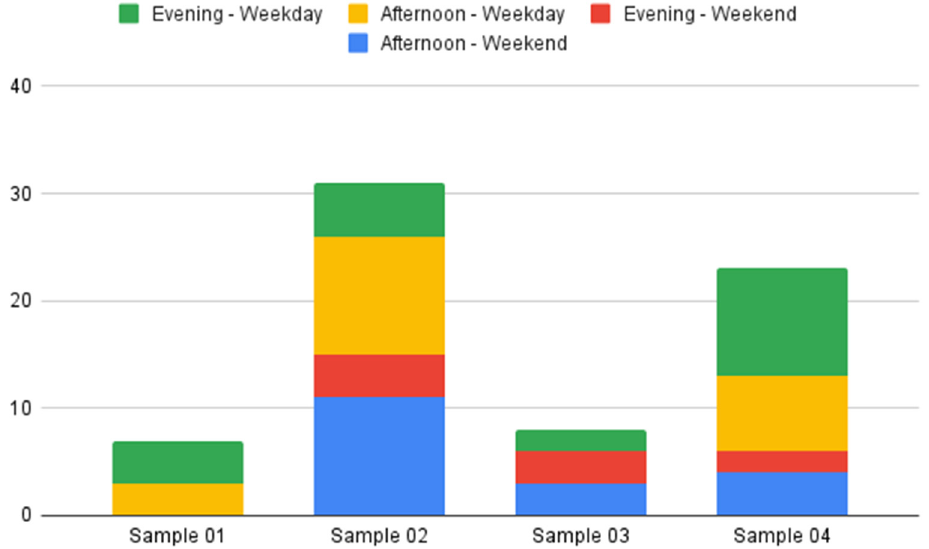
Figure 4. The total number of visitors during the behavior map observation.